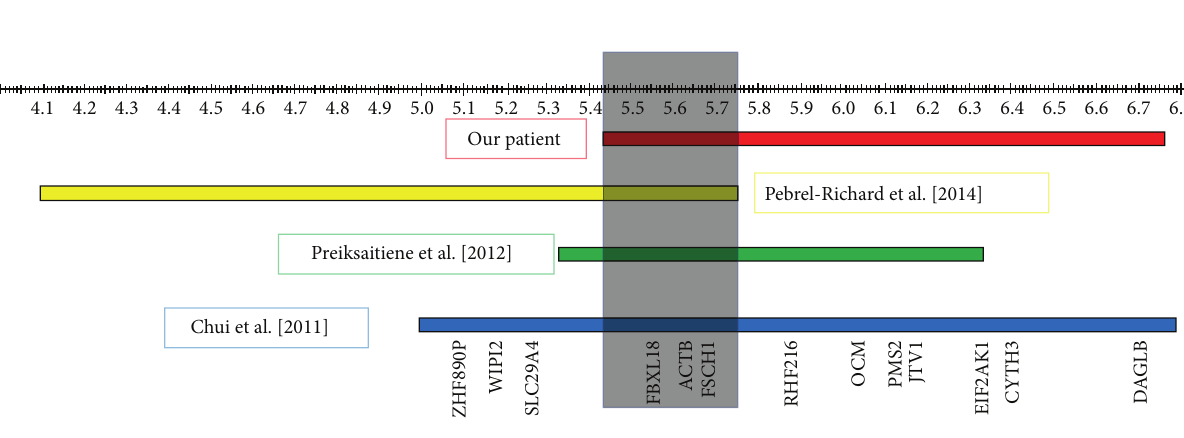
Figure 3: Graphic representation of chromosome 7 with array CGH results Arr 7p22.1 (5,436,367–6,762,394) × 3 in our patient as well as in the patients reported by Chui et al. [4], Preiksaitiene et al. [1], and Pebrel-Richard et al.